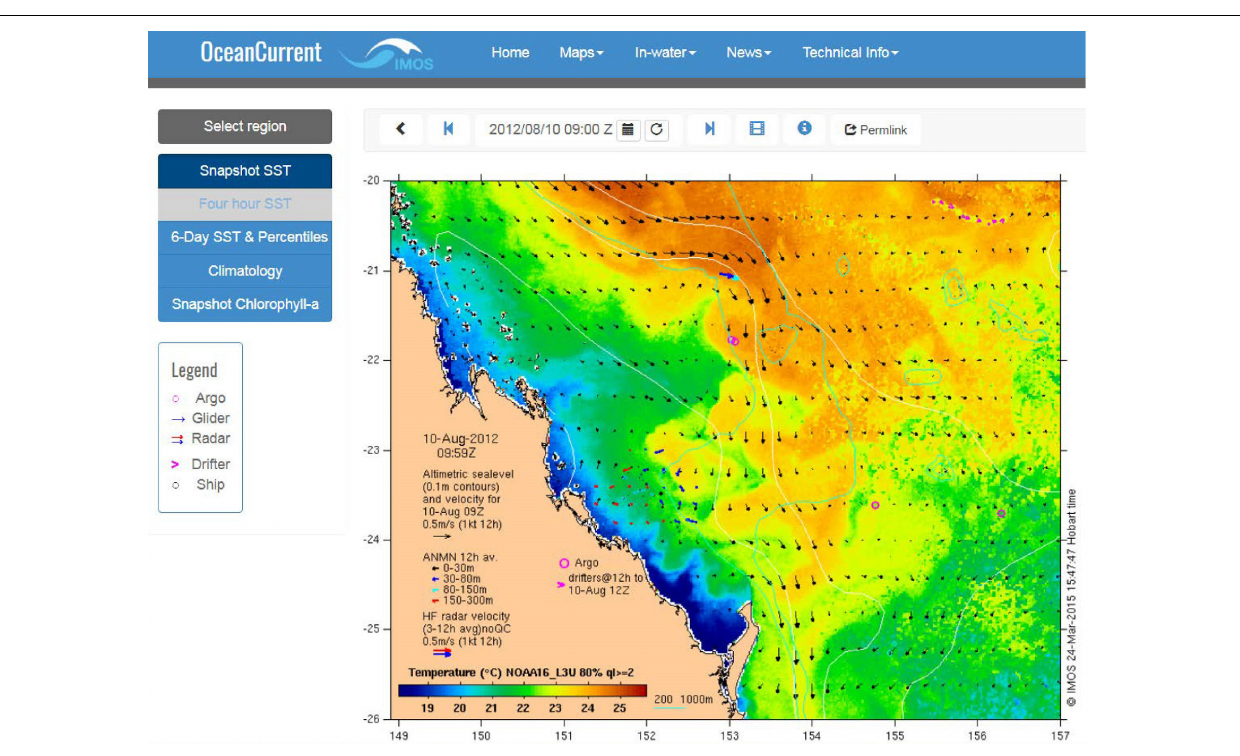
FIGURE 12 | Screen capture of the IMOS OceanCurrent map of the Southern Great Barrier Reef August 10, 2012. Source: IMOS